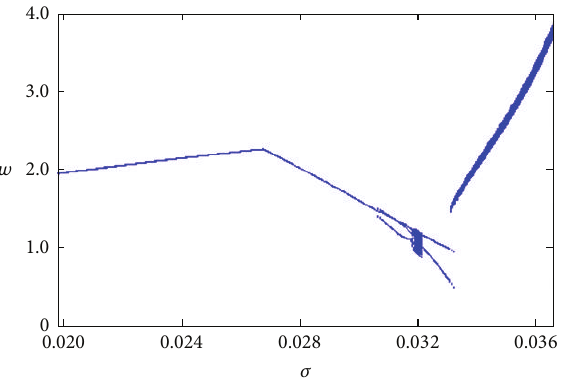
Figure 3: Bifurcation diagram varying with 𝜎 when 𝑘 = 1 .